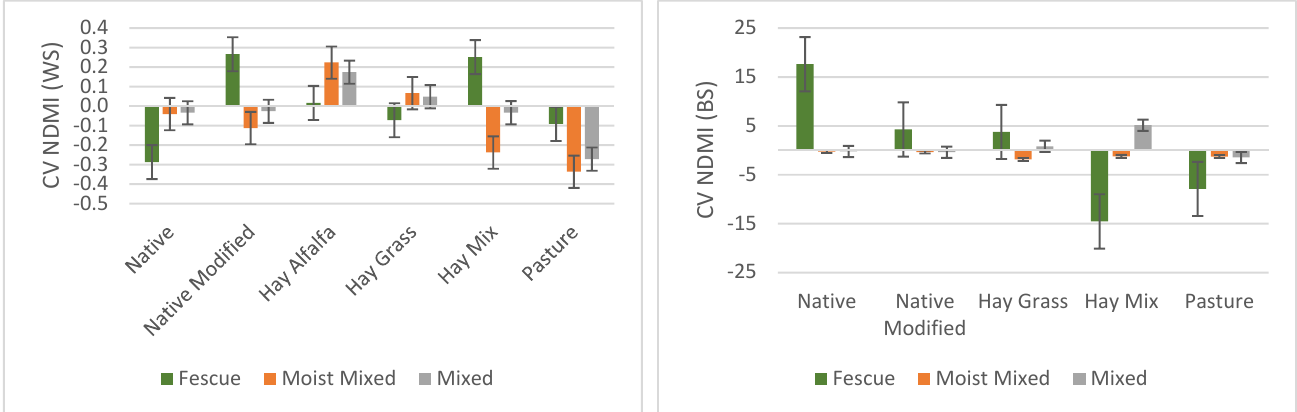
Figure 7. The within-sites (WS) and between-sites (BS) NDMI coefficient of variation (CV) for six land cover types located at three ecoregions.